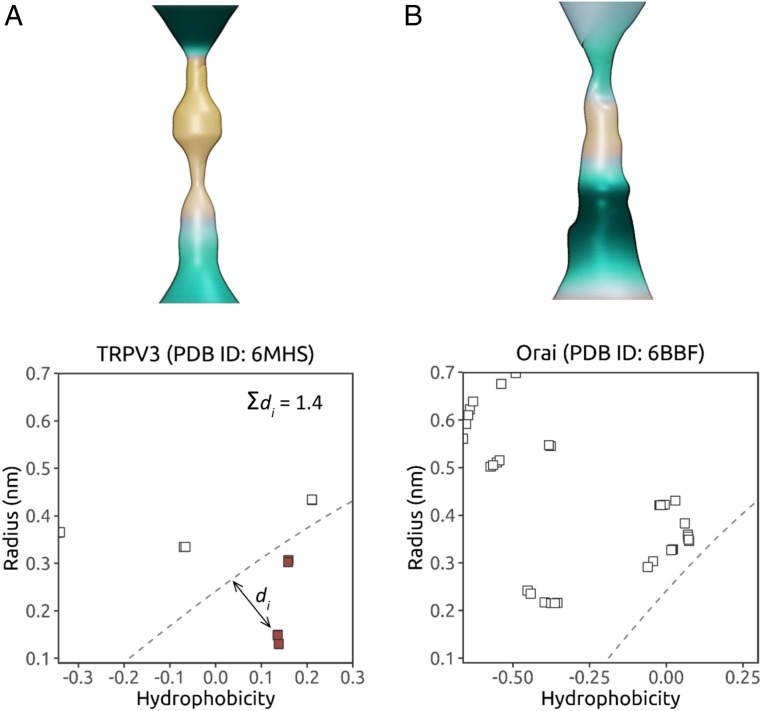
Illustration of the heuristic prediction approach using 2 recent structures of the TRPV3 channel in a nonconductive sensitized conformation (PDB ID code 6MHS) (A) and the CRAC channel Orai in an open conformation (PDB ID code 6BBF) (B). Pore radius and hydrophobicity surfaces (with the pale-brown color corresponding to maximum hydrophobicity) are shown for the transmembrane domains of both structures. In the 2 graphs, for each pore-lining side chain, the channel pore radius at the residue is plotted against the corresponding local hydrophobicity value. The sum of shortest distances between the dashed (1 RT) contour line and all points falling below it (colored red) is then used as a score for identifying closed gates. A structure is predicted to be in a nonconductive state if it has a value of Σd > 0.55.